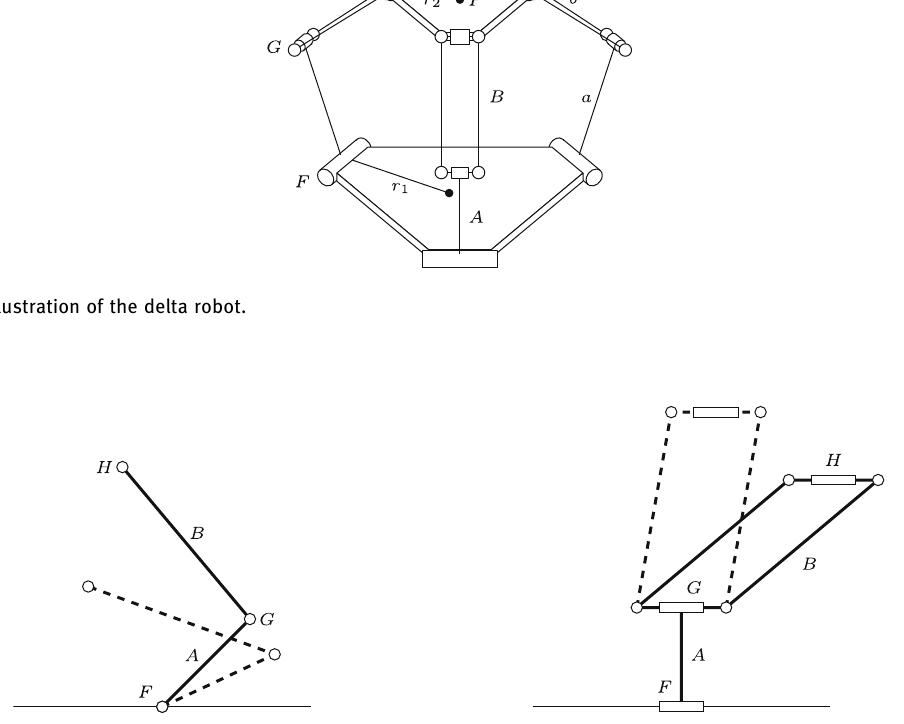
Figure 7: Illustration of the delta robot.